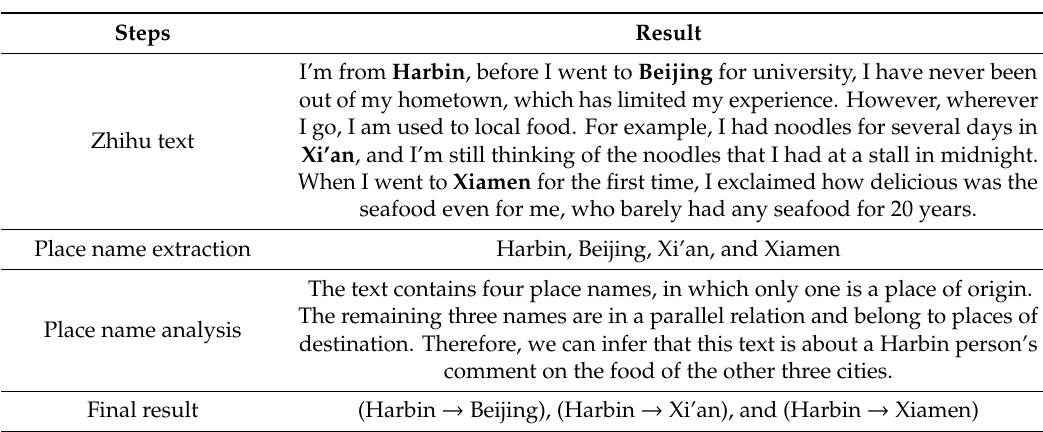
Table 2. Sample of parallel place name